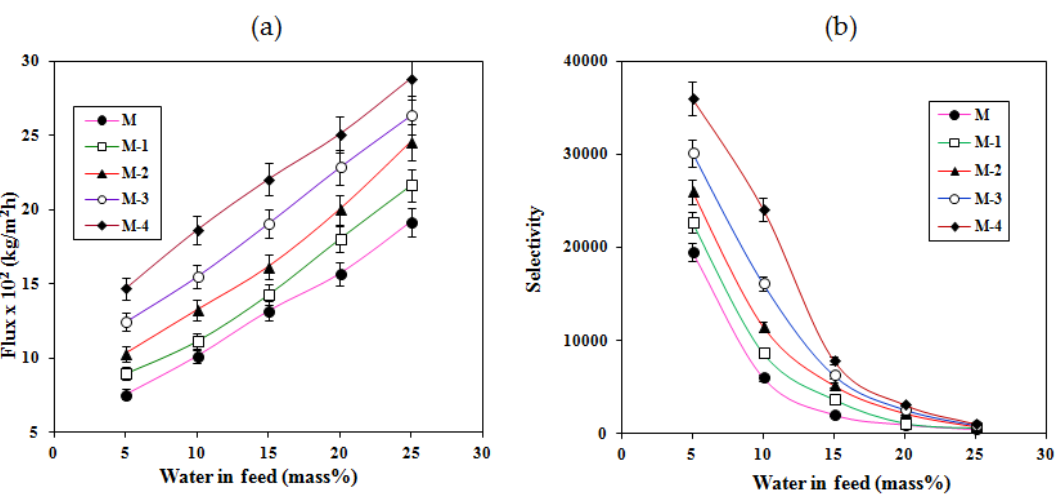
Figure 6. Variation of the ( a ) total pervaporation flux and ( b ) separation selectivity with composition of the feed for crosslinked NaAlg and related membranes containing TiO 2 at 30 °C.